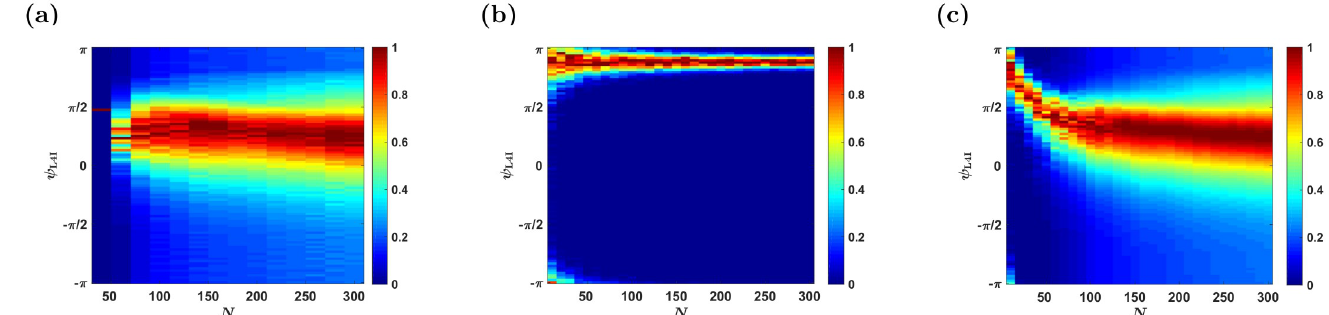
Fig 4. The effects of population size. The distribution of the preferred phases of L4I neurons, κ L4I , is shown as a function of N for different sources of variability. In each column (value of N ), the non-normalized distribution: Pr( ψ )/max{Pr( ψ )}, is presented by color. (a) The temporal distribution of the preferred phase of a single L4I neuron as a result of STDP dynamics without quenched disorder or averaging (see Modeling pre-synaptic phase distributions) is presented. (b) Distribution due to quenched disorder without STDP. The distribution of L4I neurons in the randomly pooling model was estimated from 1000 trials of drawing the preferred phases of N VPM neurons in an i . i . d .manner from Eq (1). (c) The distribution due to both quenched disorder and STDP dynamics is shown. Unless stated otherwise, the parameters used in these graphs are as follows: � n ¼ n = ð 2 p Þ ¼ 7 Hz , κ VPM = 1, γ = 0.9, D = 10hz, d = 3ms, ϕ 0 = 5 π /6. For the STDP we used the temporally exponential asymmetric kernel, Eq (9), with τ − = 50ms, τ + = 22ms, μ = 0.01, α = 1.1, and λ = 0.01.